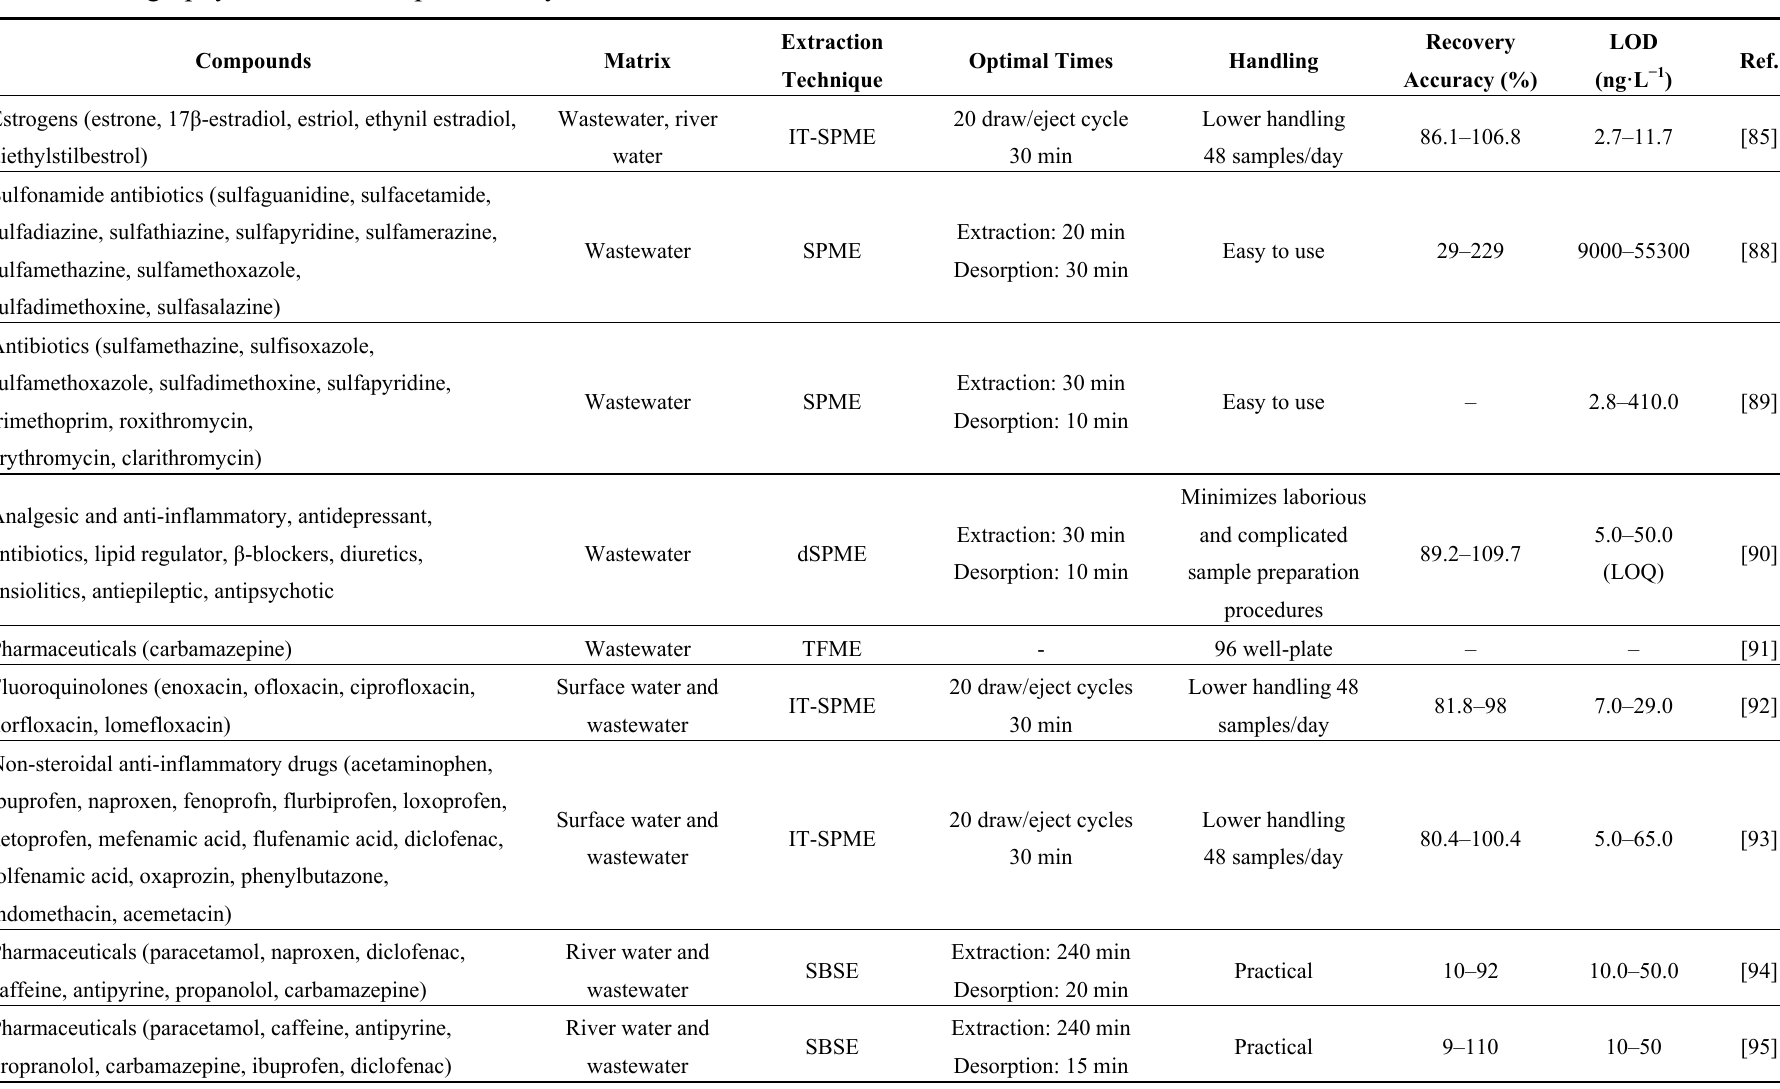
Table 3. Microextraction techniques to determine hormones and pharmaceuticals in environmental water samples by liquid chromatography-tandem mass